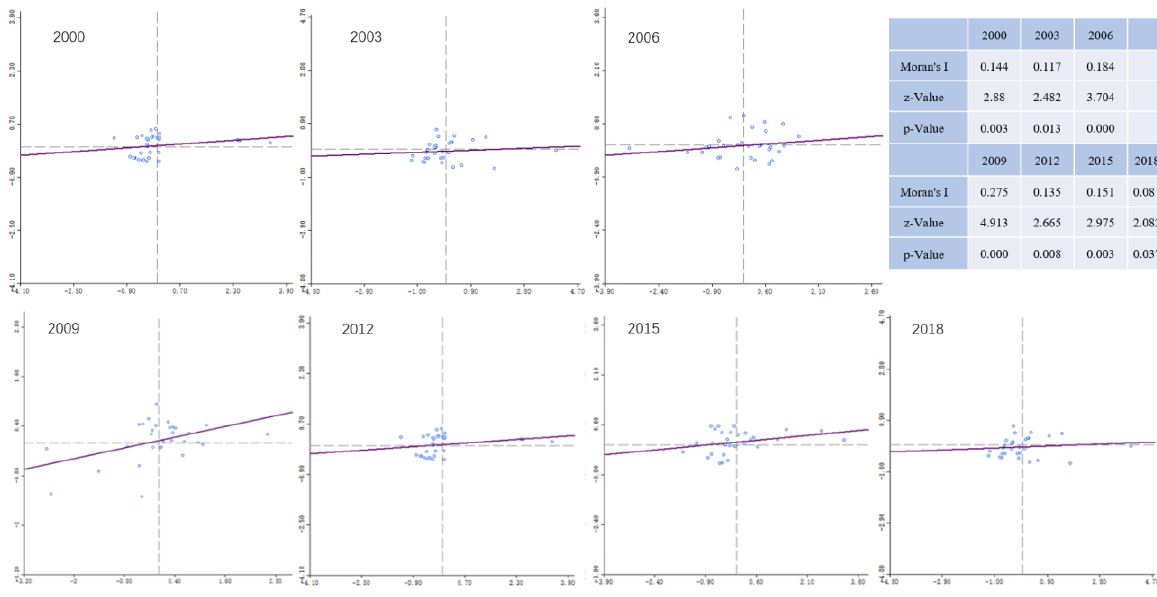
Figure 15. Moran’s I statistics of household number growth rate (HNGR).